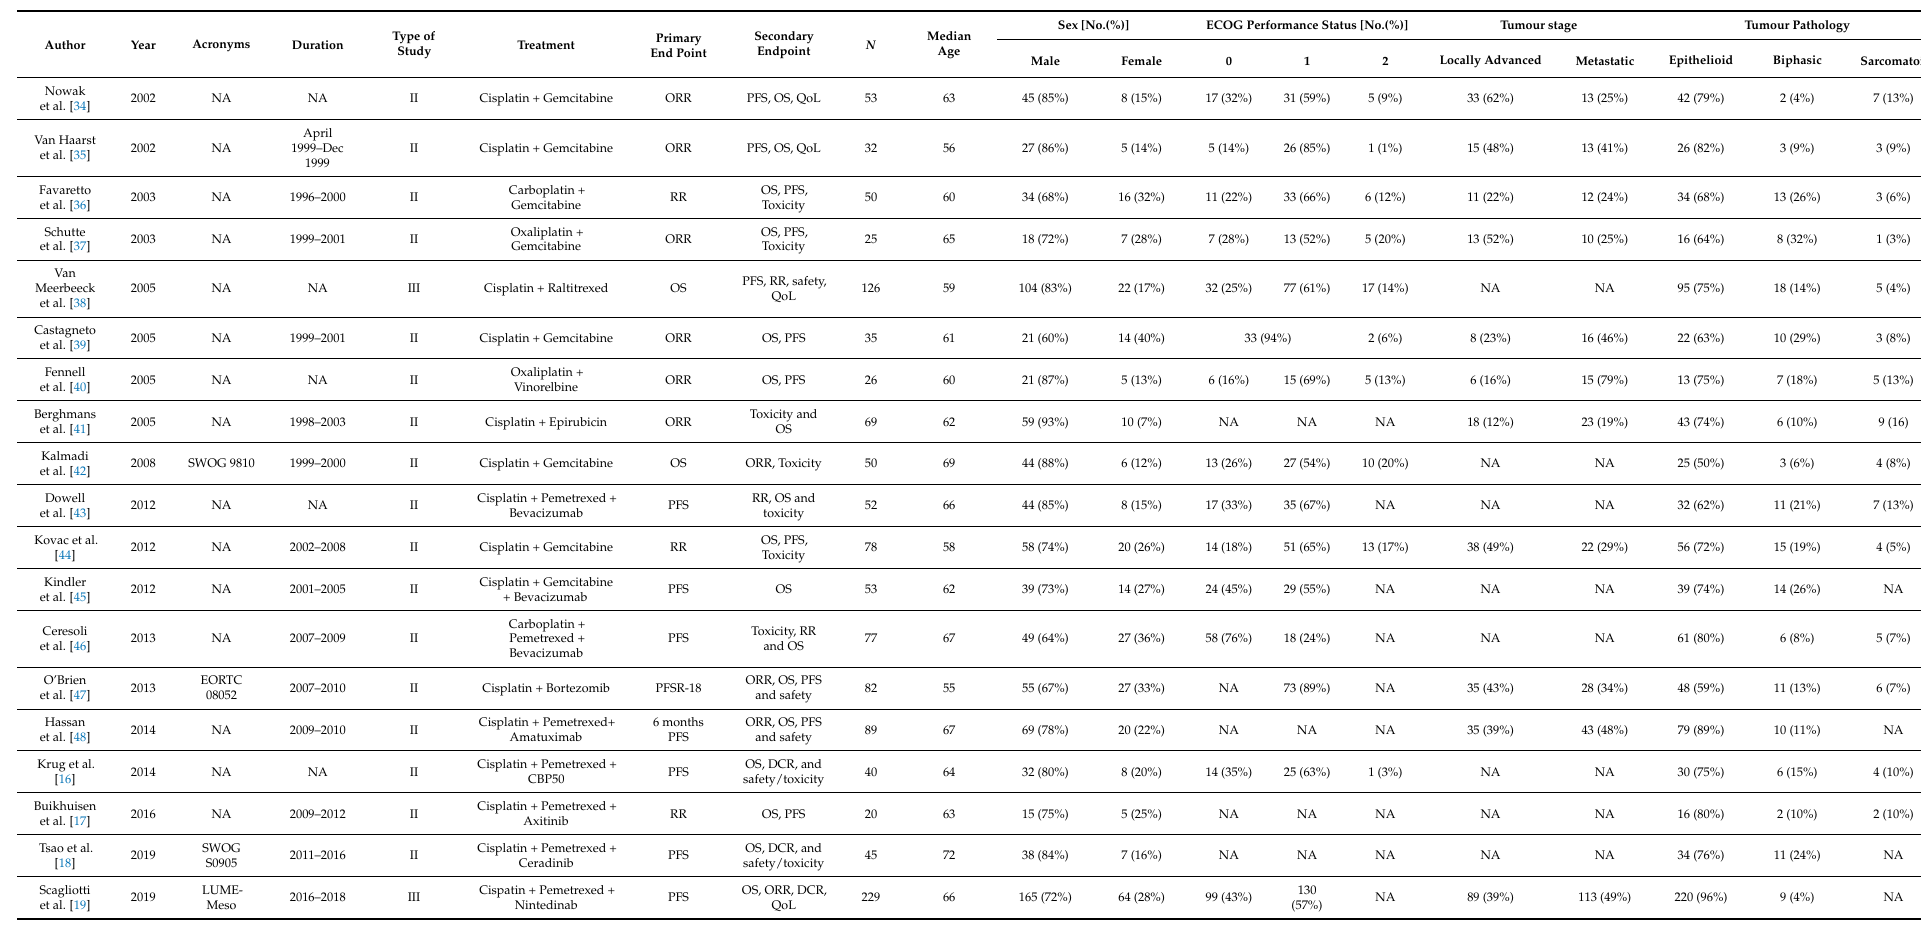
Table A1. Demographic data for patients with malignant pleural mesothelioma treated with experimental therapies, negative on phase II/III